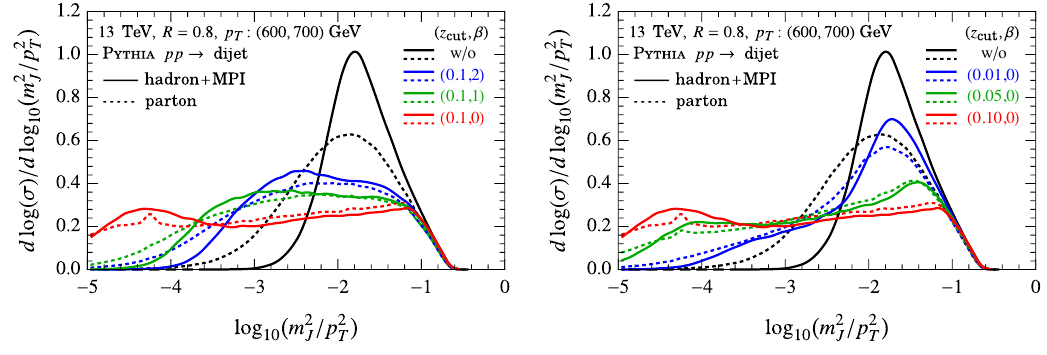
Figure 4 . Soft-Drop jet mass distributions from Pythia simulations of pp The distributions are given at both parton level (dotted) and hadron level with MPI e(cid:11)ects (solid). The jet mass distribution without grooming is also shown for comparison (black curves). For the soft drop curves the left panel (cid:12)xes z cut = 0 : 1 and varys (cid:12) = 0 ; 1 ; 2, while the right panel (cid:12)xes (cid:12) = 1 and varies z cut = 0 : 01 ; 0 : 05 ; 0 :